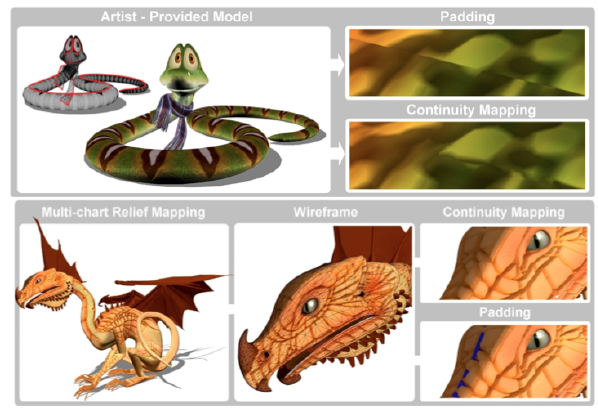
Fig. 6. Continuity Mapping of Multi-chart textures 4) skylineEngine: An urban procedural modeling